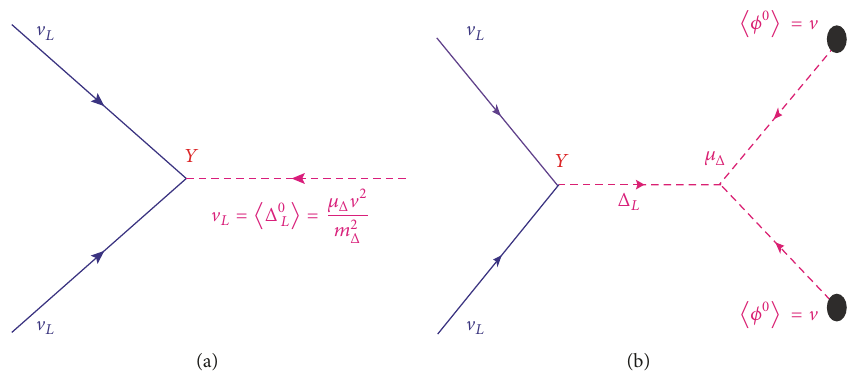
Figure 1: Schematic representation of generation of type-II term corresponding to (4) (a) and combination of (5)(b) where dashed line as triplet propagator supplies the damping factor 𝑀 −2 Δ to the induced vev V 퐿